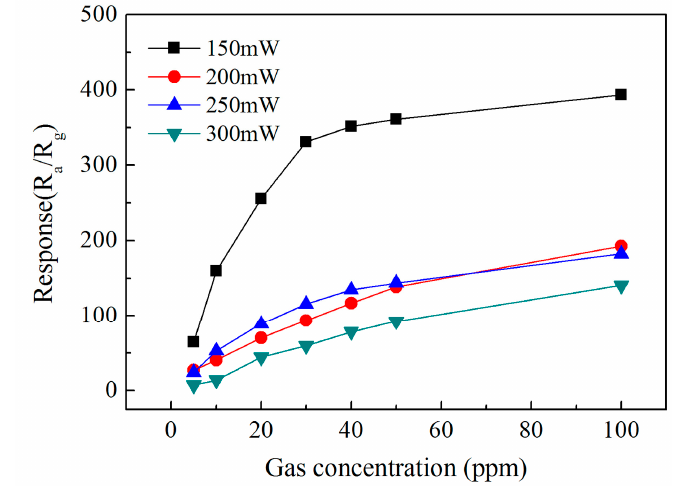
Figure 11. The gas sensing response characteristic curves at different heating power consumptions to 100 ppm NO 2.